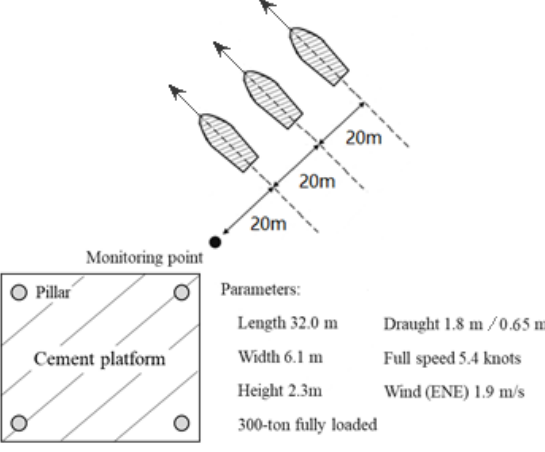
Figure 2. A sketch of the field experiments.